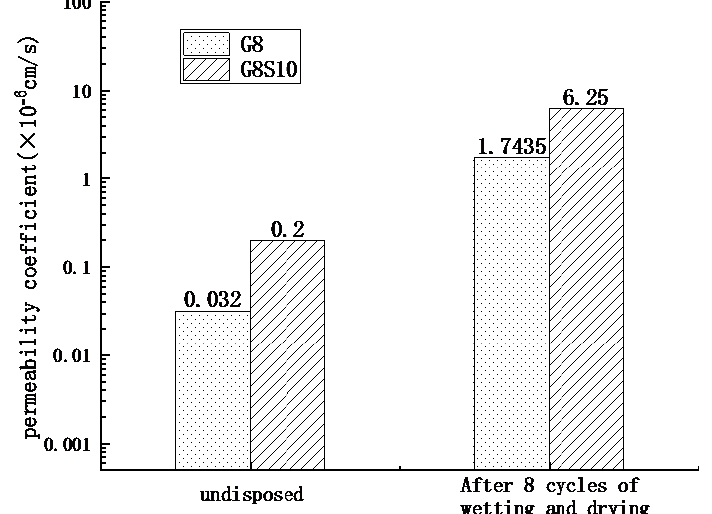
Figure 6. Permeability coefficient of the sample before and after the wetting and drying cycle.